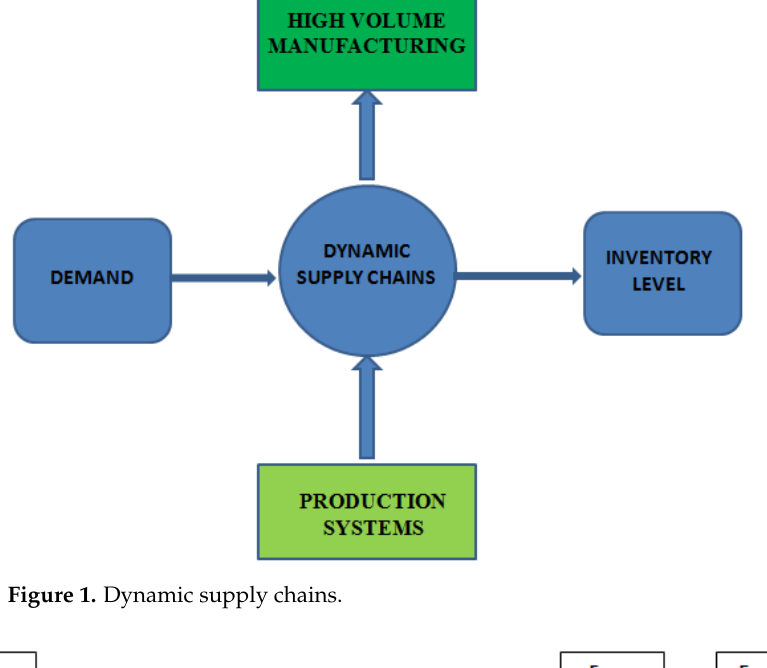
Figure 1. Dynamic supply chains.